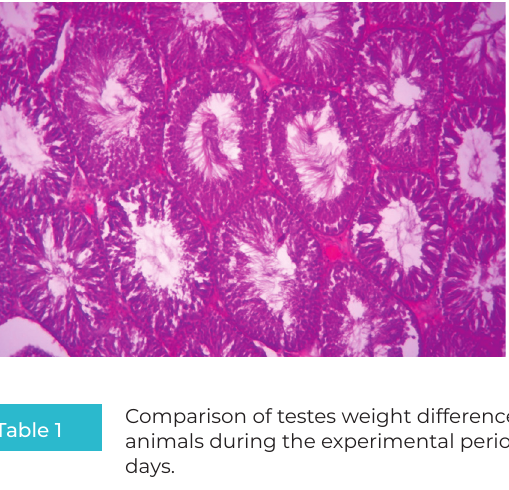
Figure 2 - Photomicrograph of group B, section of the testis administered with red wine (x400)(H/E) shows testicular tissue with enhanced perfusion (EP) and continuous maturation of the sperm cells (SC).